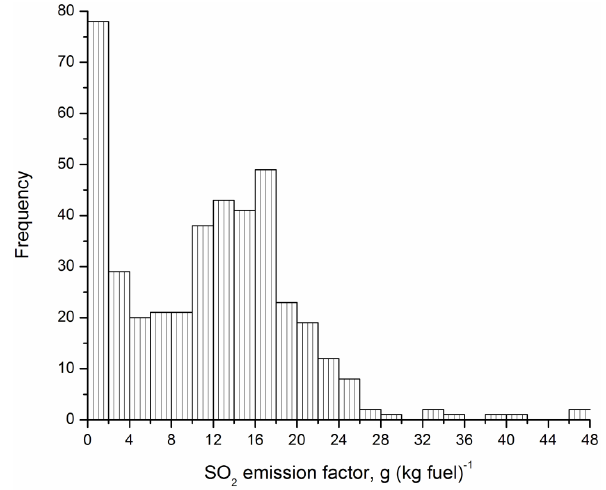
Table 1. Average EF of metal and water-soluble ionic components of aerosols observed in ship plumes. The unit is mg (kg fuel) − 1 . NO 3 − SO 42 − Cl − Na + NH 4 + K + Mg 2 + Ca 2 + V ∗ Ni ∗ Sample A 150 ± 10 570 ± 30 180 ± 10 Sample B 190 ± 10